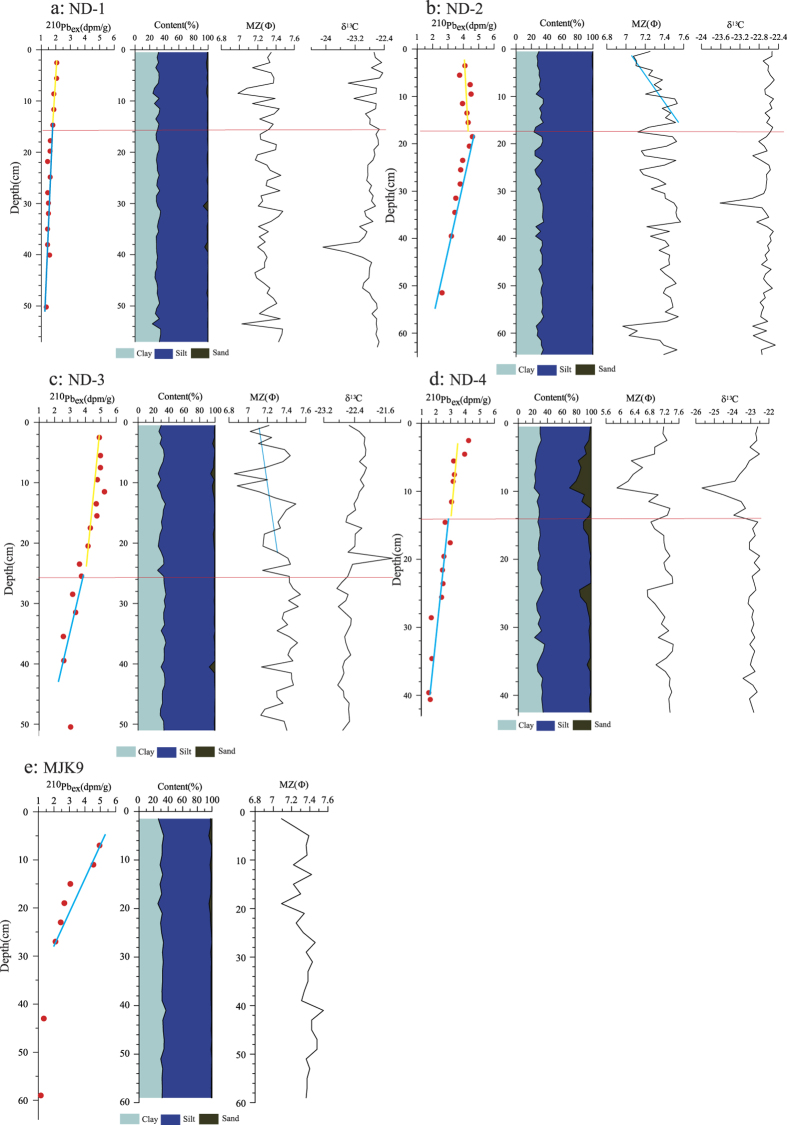
The down-core variations of 210Pbex, grain size, average particle size and δ13C in the cores of ND-1 (a), ND-2 (b), ND-3 (c), ND-4 (d) and MJK9 (e).